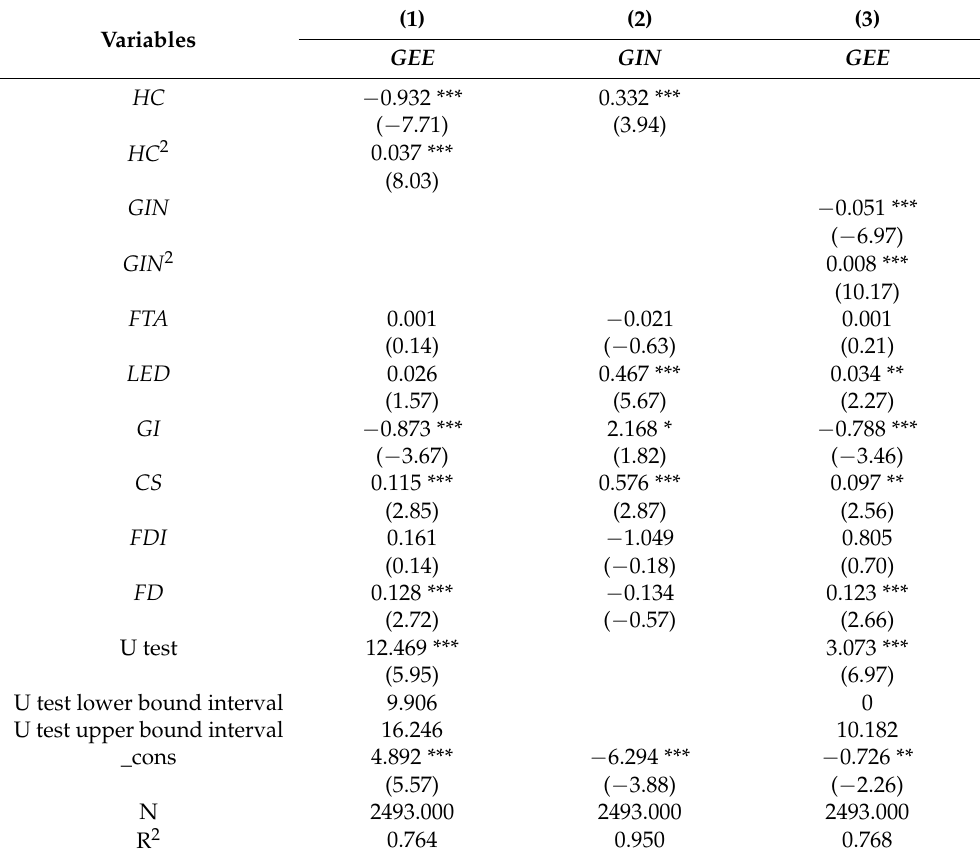
Table 4. Empirical results of the relationship between HC, green innovation and GEE.